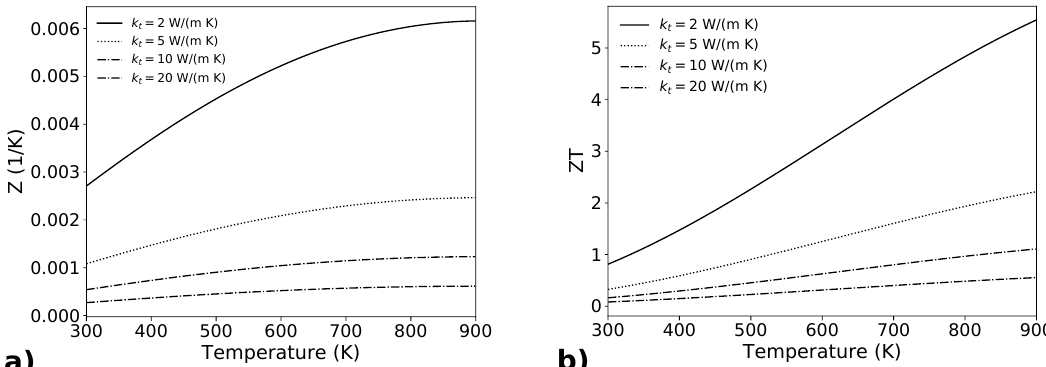
Figure 5. The factor Z (Panel ( a )) and the figure of merit ZT (Panel ( b )) are reported as a function of temperature, for the optimum thermoelectric doping of n type silicon. Different curves consider different values of the thermal conductivity k t . The highest values of Z are related to k t = 2 W/(m K), achievable in rough silicon